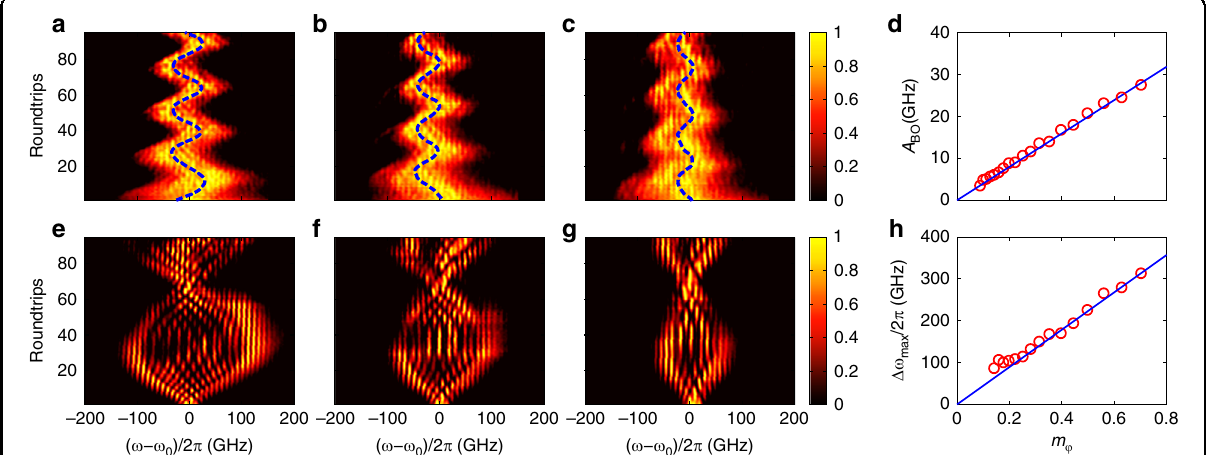
Fig. 5 Frequency BOs for different electrical attenuations. a – c Spectrum evolutions of the frequency BOs for electrical attenuations equal to 0, 3 and 6 dB when T 0 = 3.5 ps and τ = 4 ps. The blue curves denote the trajectories of the centre frequency. d Oscillation amplitude A BO as a function of the modulation depth m φ . The red circles and blue line denote the experimental and theoretical results, respectively. e – g Breathing patterns of the frequency BOs corresponding to a – c when T 0 = 140 ps and τ = 1.5 ps. h Maximum spectral broadening Δ ω max versus m φ when T 0 = 140 ps and τ = 1.5